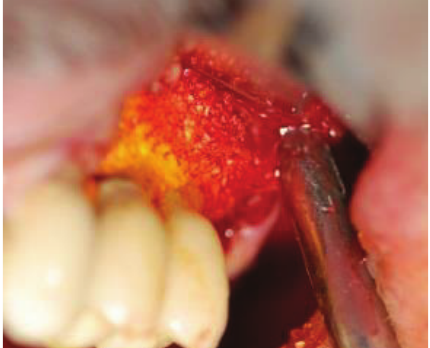
Figure 6: Debridement of the implant surfaces using air powder abrasion for 60 seconds.